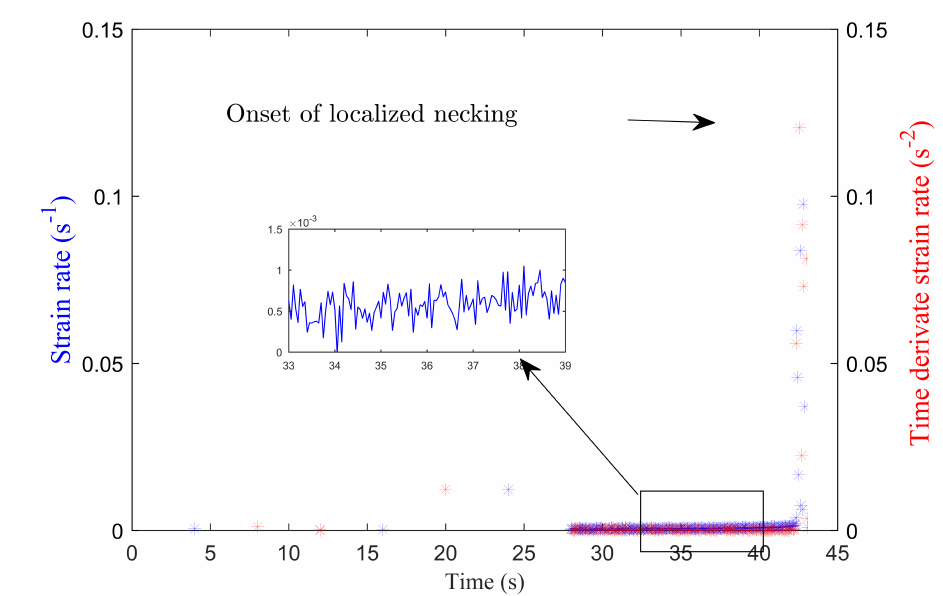
Figure 9. Determination of the onset of necking using the time-dependent method for the circular sample of pure Cu (65 mm): evolution of major strain rate (blue curve), major principal acceleration history (red